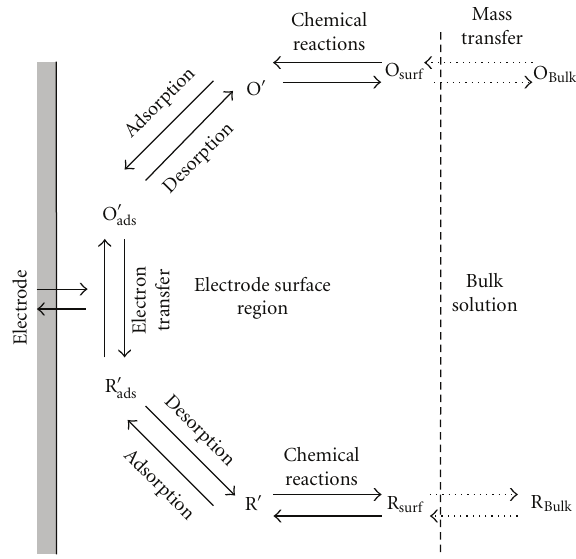
Figure 1: Pathway of a general electrode reaction (see